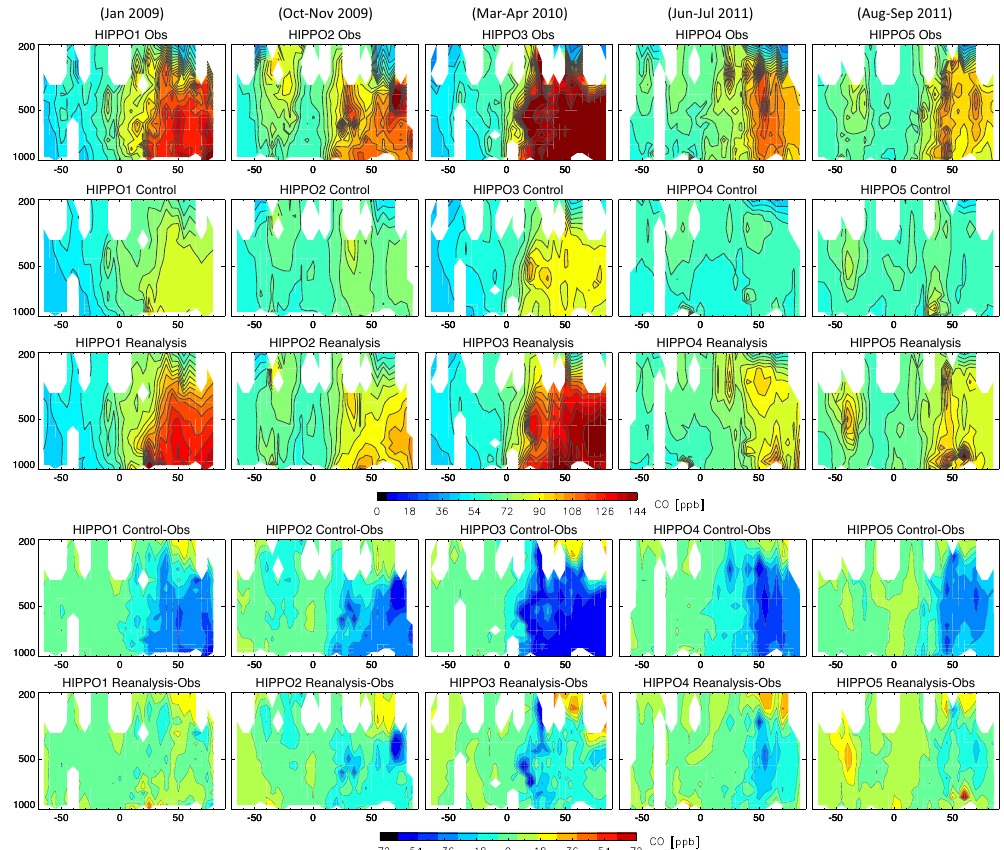
Figure 13. Same as in Fig. 9, but for CO concentration (in ppb, from first to third row) and its absolute difference (in ppb, from fourth to fifth row) obtained from HIPPO aircraft